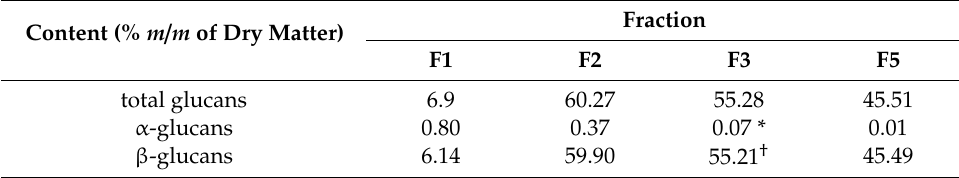
Table 3. Contents of glucans in the polysaccharidic